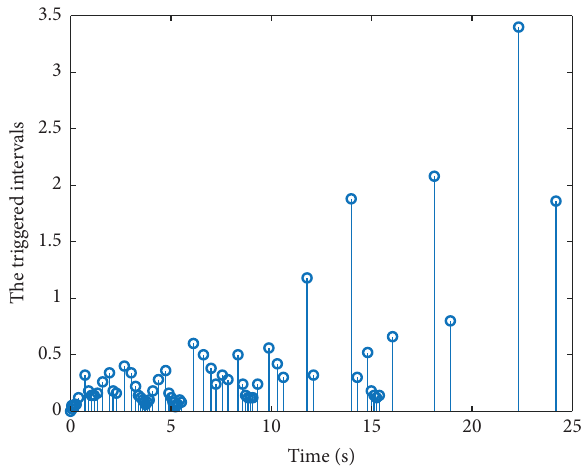
Figure 6: Te triggering instants for MAETP.